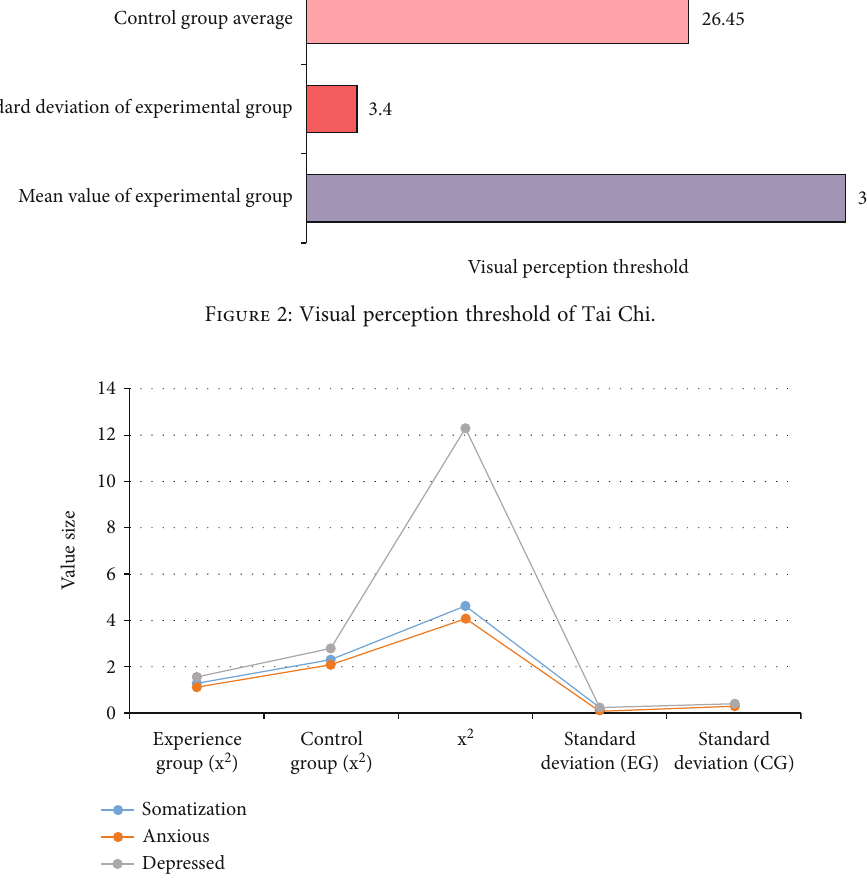
Figure 3: College students SCL-90 practicing Tai Chi once a week and 3 times a